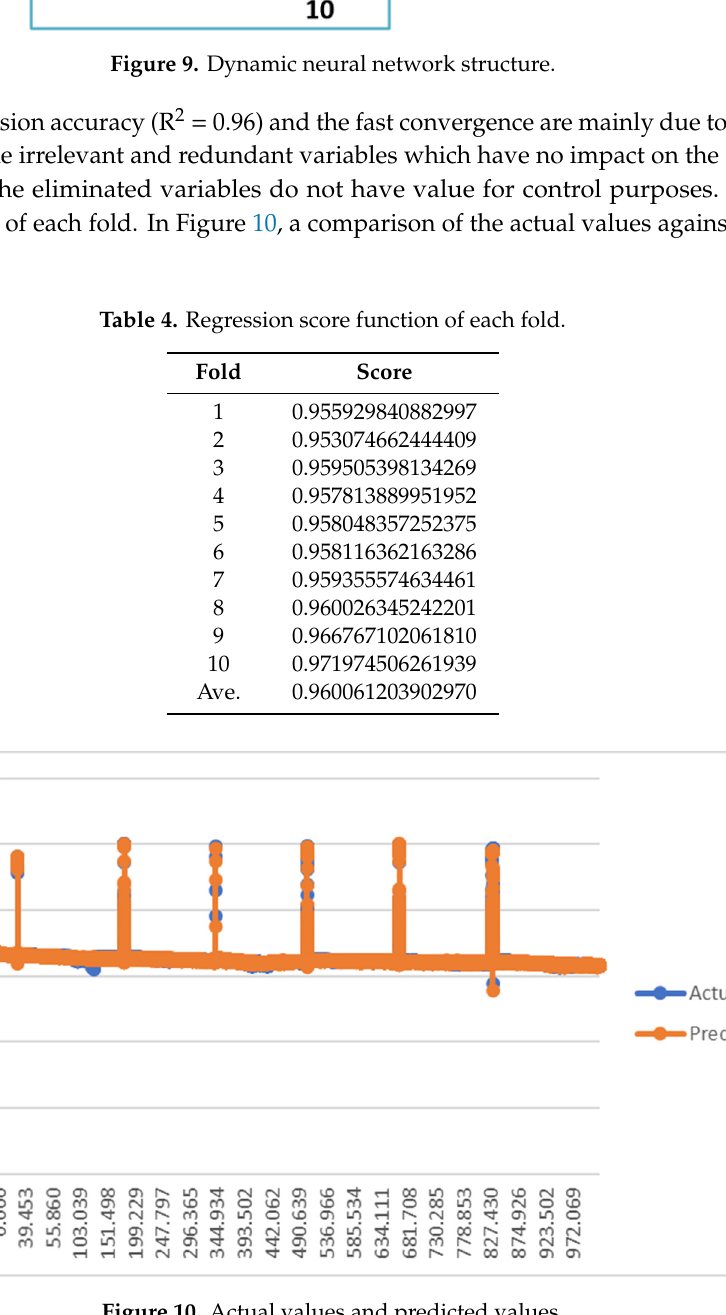
Figure 9. Dynamic neural network structure.